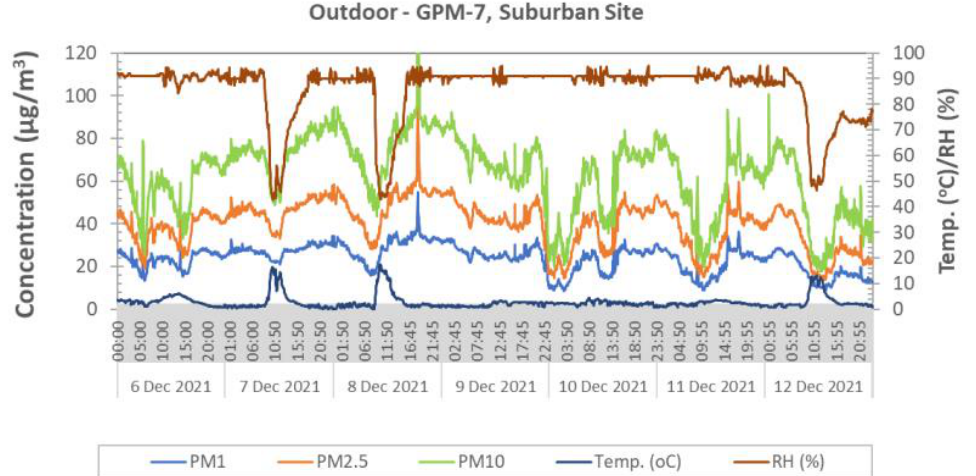
Figure 17. Temporal PM and microclimatic data for the GPM sensor at the suburban site (outdoor) recorded between 6 and 12 December, 2021 (sampling rate: 5 min, n = 2018).